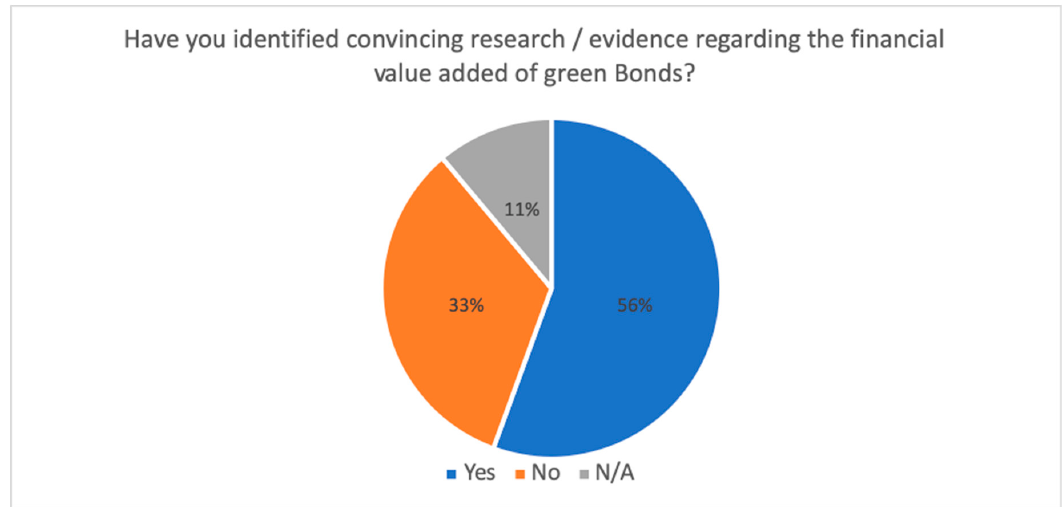
Figure 3. Clarity on the benefits of green bonds among stakeholders. Source: interviews with 11 experts across issuers, investors, and intermediaries, conducted in December 2019.